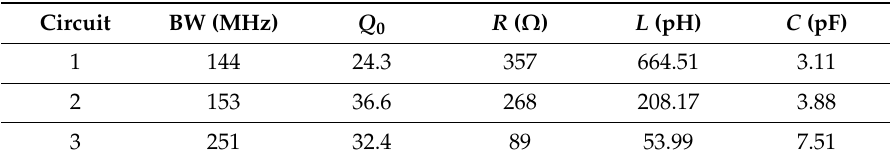
Figure 12. The comparison of equivalent circuit’s return loss with simulated and measured results of return loss of the proposed antenna. Table 2. Calculated equivalent circuit parameter values. Table 2. Calculated equivalent circuit parameter values.